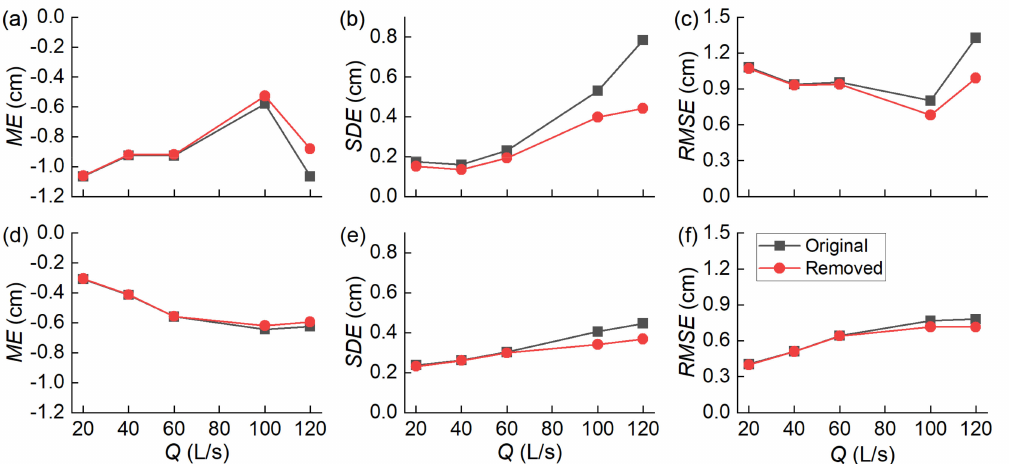
Figure A6. Error statistics for the corrected models with and without the removal of elevation errors < − 0.02 m for MR1 ( a – c ) and MR2 ( d – f